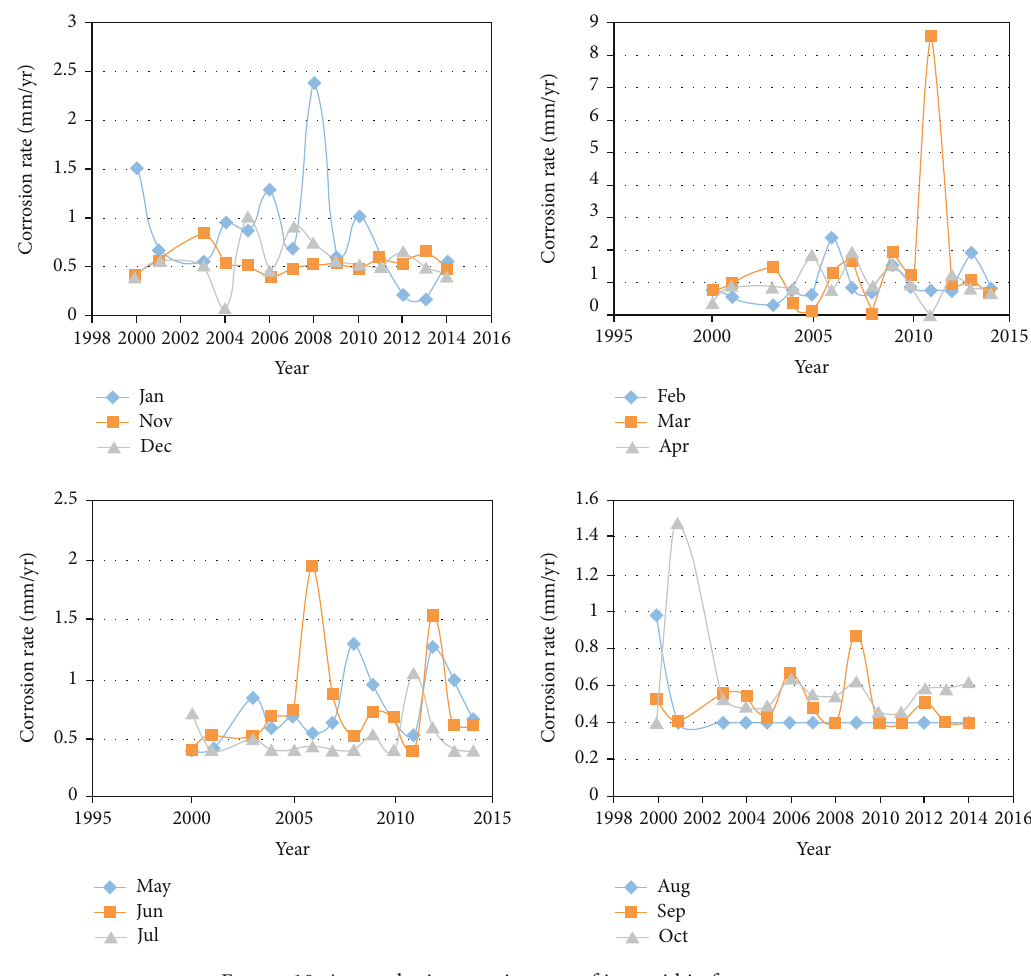
Figure 10: Atmospheric corrosion rate of iron within four